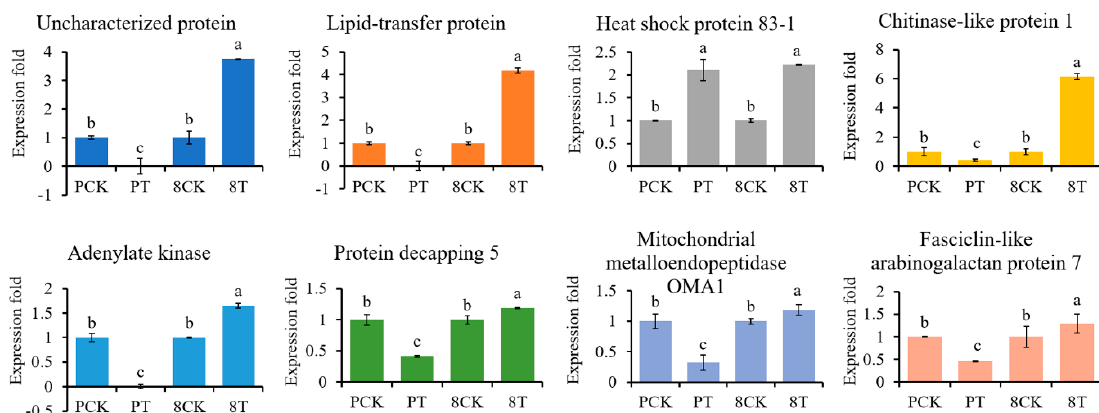
Figure 6. qRT-PCR analysis of gene expression fold change for eight proteins. PCK: P138 under normal conditions, PT: P138 under 180 mM NaCl stress, 8CK: 8723 under normal conditions, 8T: 8723 under 180 mM NaCl stress. Data are presented as the mean ± standard deviation. Lowercase letters indicate a significant difference at the 5% level.